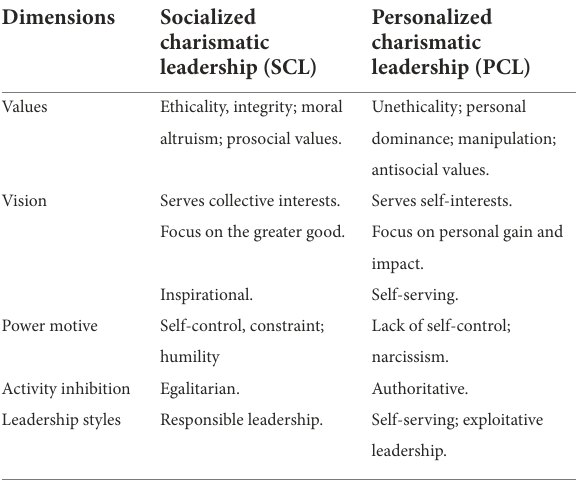
TABLE 1 Distinction between socialized and personalized charismatic